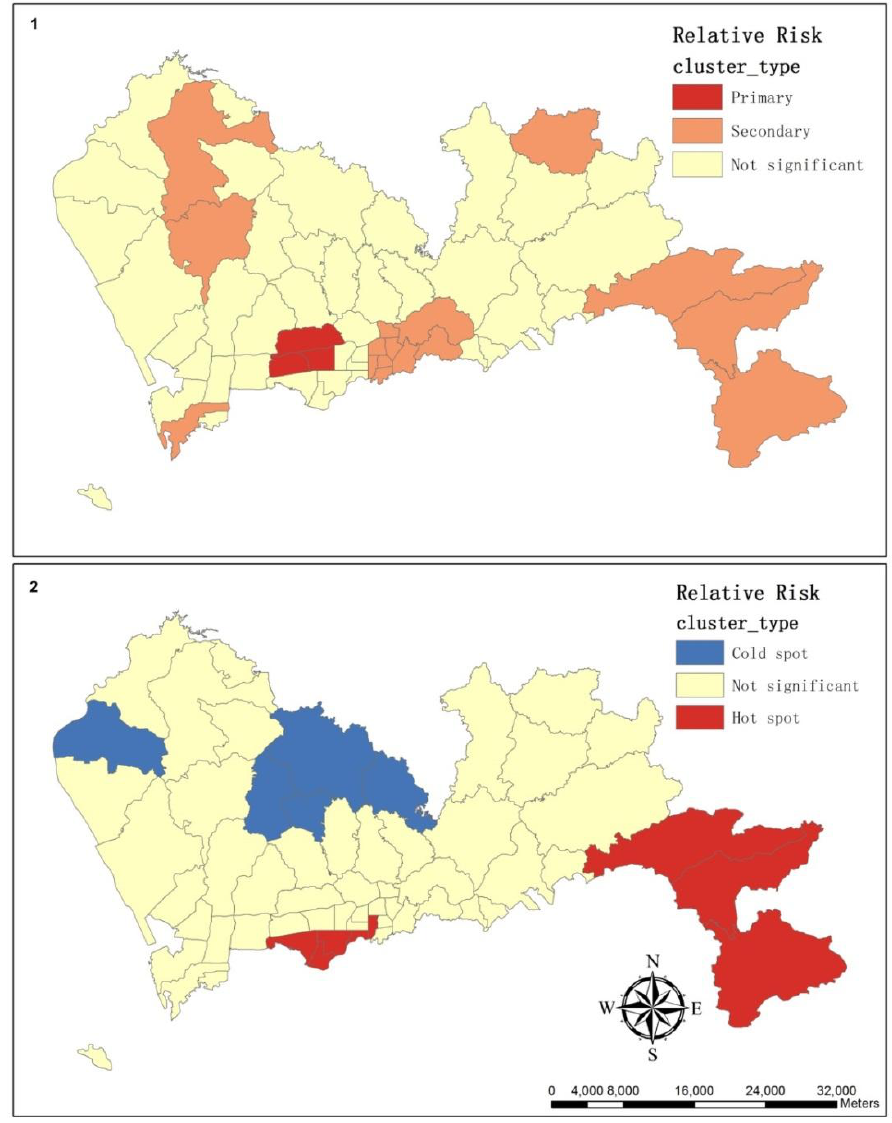
Figure 6. These maps illustrate the cluster of relative risk as estimated by SatScan ( 1 ) and as estimated by the hot spot analysis of ArcGIS ( 2